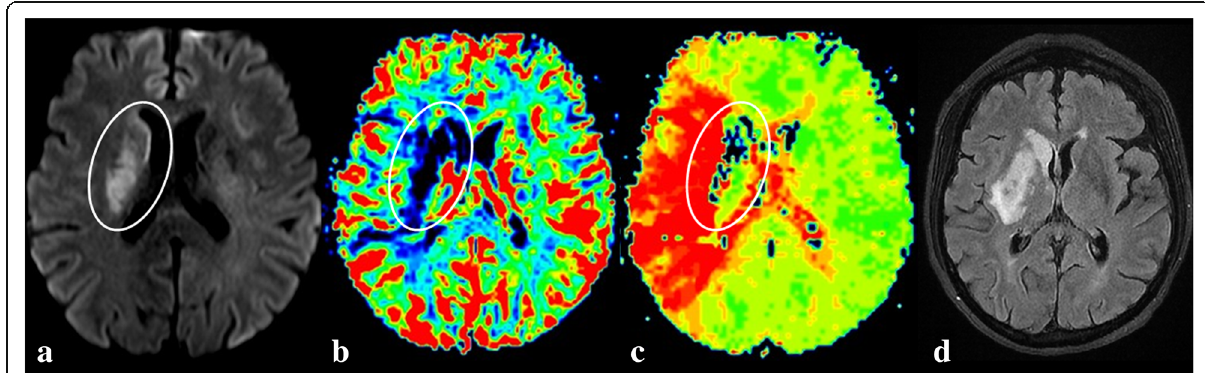
Fig. 5 A 67-year woman was admitted with a wake-up stroke. Clinically, she presented with severe right MCA infarct symptoms (NIHSS 14). Since the time of onset of the stroke could not be determined, MRI was performed. The diffusion-weighted trace image ( a ) shows an infarct core with diffusion restriction in the right basal ganglia. The parametric MR perfusion maps ( b , cerebral blood volume (CBV) and c , time to peak (TTP)) show a mismatch indicating a large penumbra, i.e., area of potentially salvageable brain tissue. Subsequently, a successful mechanical thrombectomy was performed and the patient had a substantial recovery (NIHSS 3). Follow-up MRI on day 3 after treatment ( d ) shows that the core infarct remains limited within the right basal ganglia with sparing of the insular, frontal, and parietal cortex